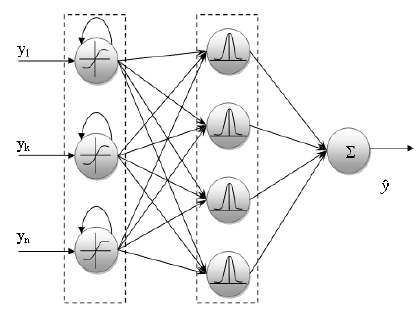
Fig. 3 . Recurrent Radial basis Function Network